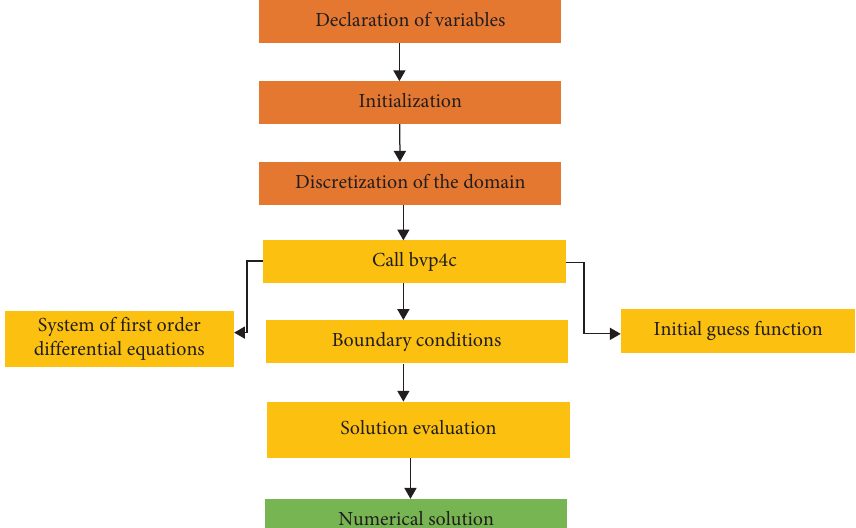
Figure 2: Flowchart of numerical scheme